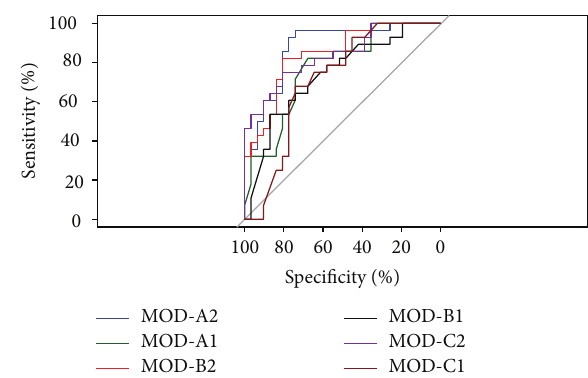
Figure 8: Comparison of ROC curves of all